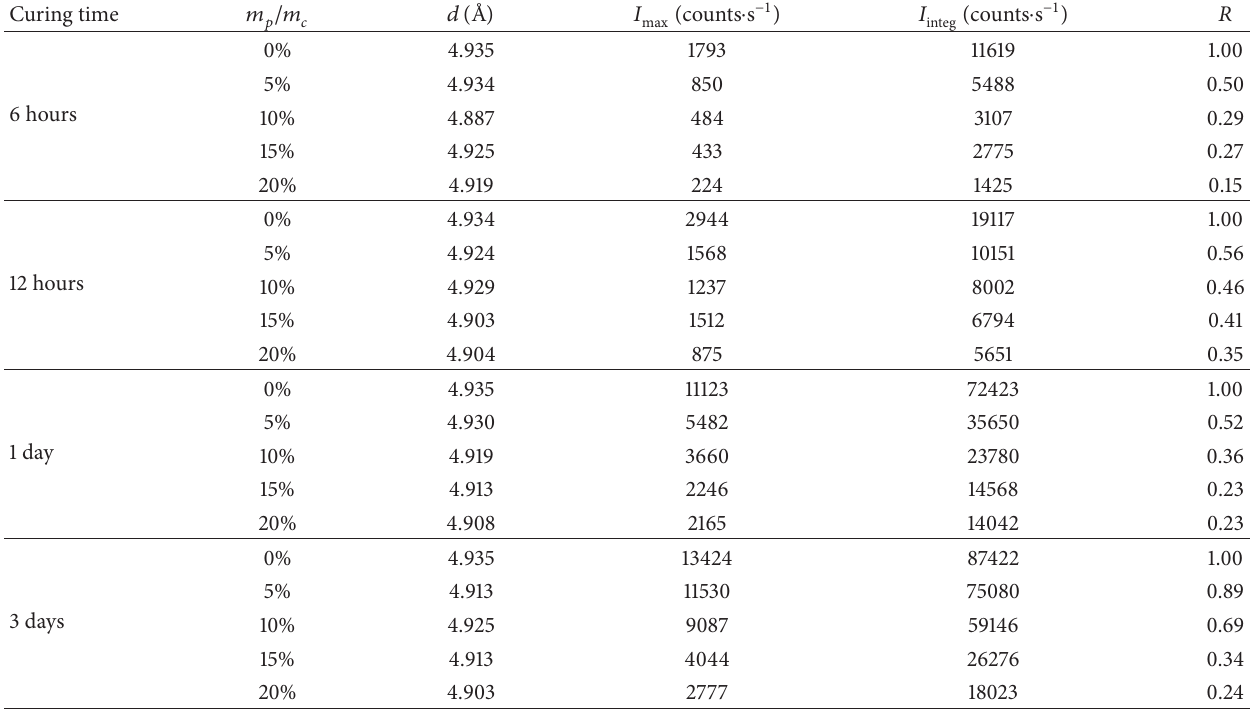
Table 7: The integrated results of XRD peak of CH in the pastes with SAE dispersion. Curing